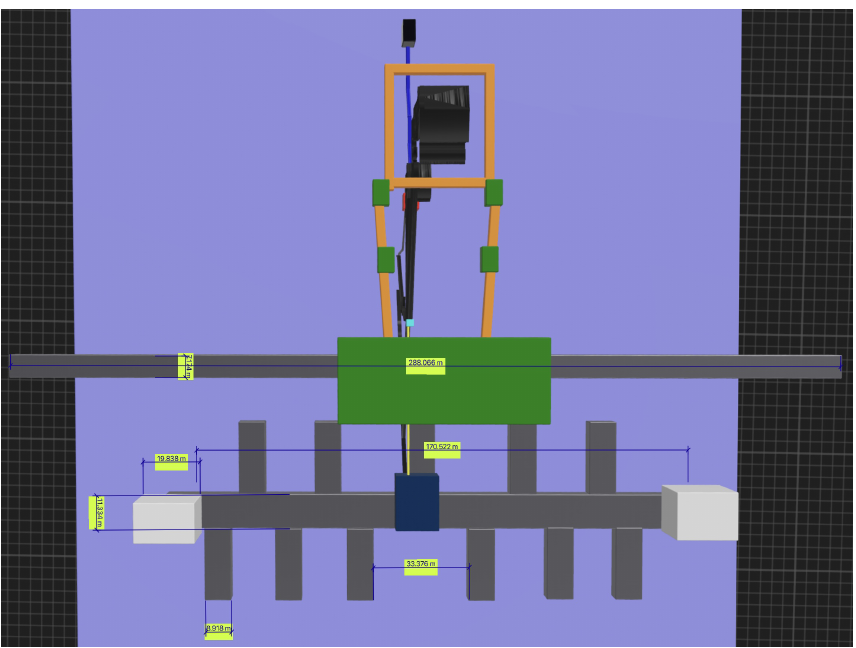
Figure 59. Measurements of the detected facilities of the pyramid. The numbers shown after the comma cannot be significant. (Top-side particular